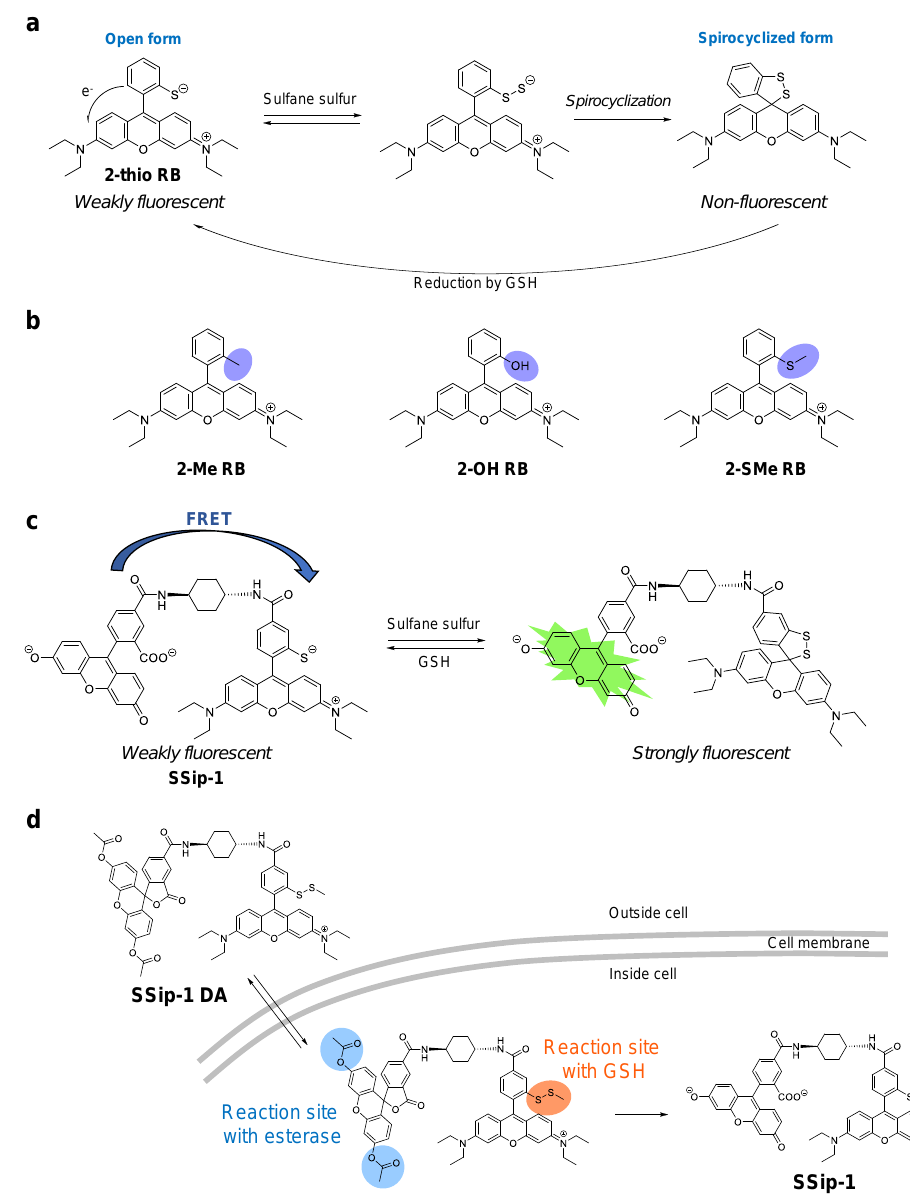
Figure 4. ( a ) Chemical structure of 2-thio RB and proposed mechanism of its reaction with sulfane sulfur and reduction by GSH. ( b ) Chemical structures of 2-Me RB, 2-OH RB, and 2-SMe RB. ( c ) Chemical structure of SSip-1 and the proposed reaction mechanism with sulfane sulfur. ( d ) Chemical structure of SSip-1 DA designed for live-cell imaging of sulfane sulfur. SSip-1 DA is expected to have high membrane permeability and to react with intracellular esterase and GSH to release SSip-1.